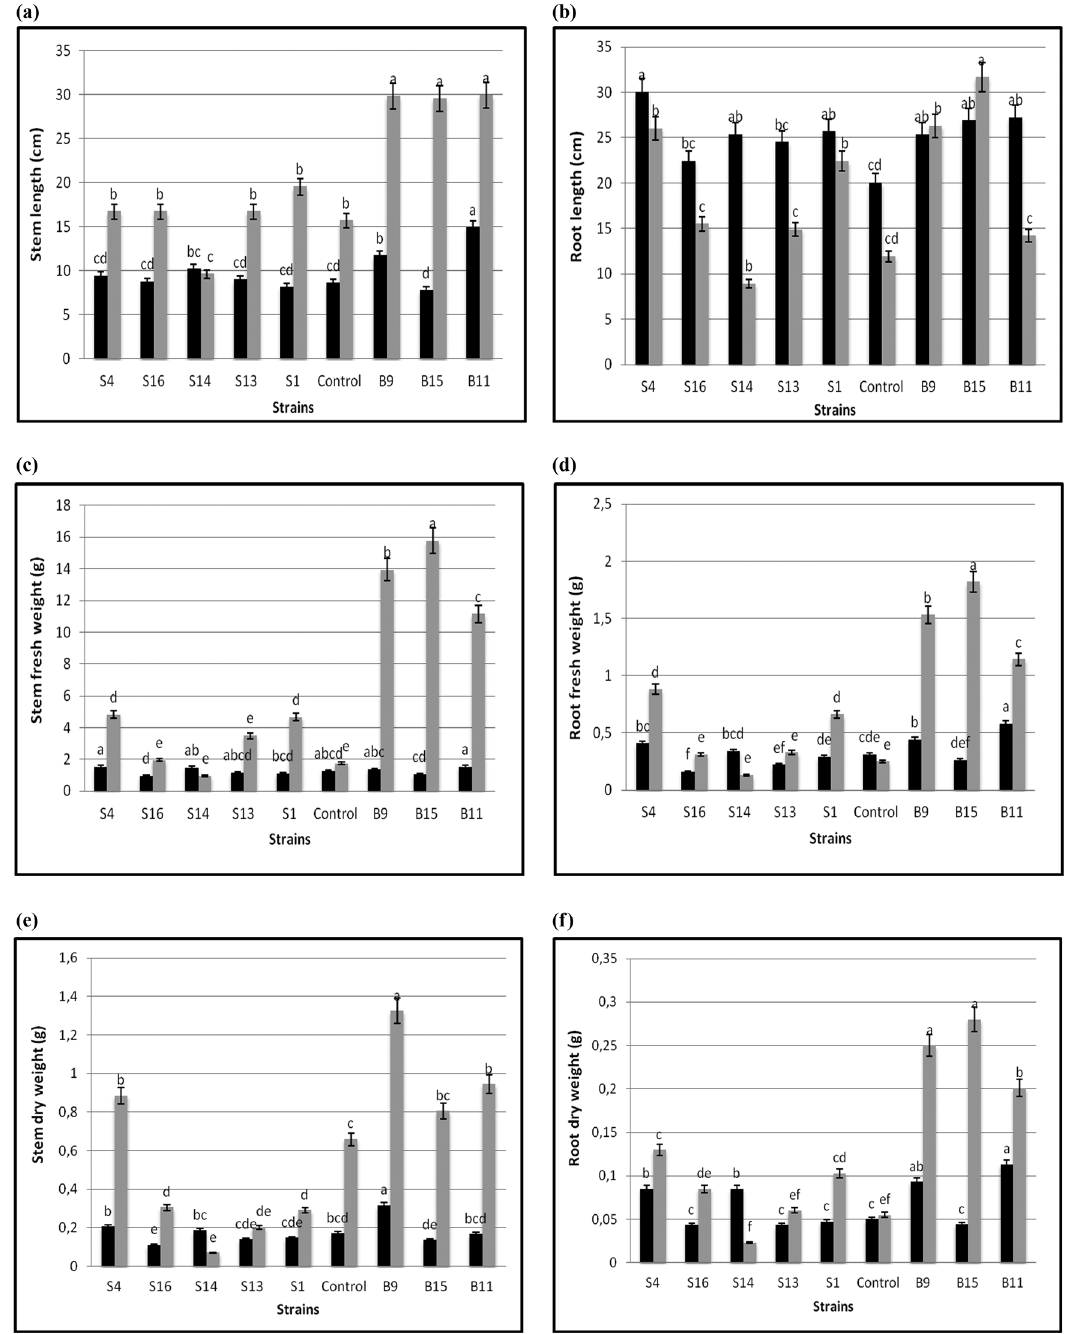
Figure 5: Growth parameters as a function of bacterial inocula of the Foolewouh variety. Di ff erent letters indicate signi fi cant di ff erences between categories ( P < 0.05 ) . Error bars indicate ± SD. ( a ) stem length, ( b ) root length, ( c ) stem fresh weight, ( d ) root fresh weight, ( e ) stem dry weight and ( f ) root dry